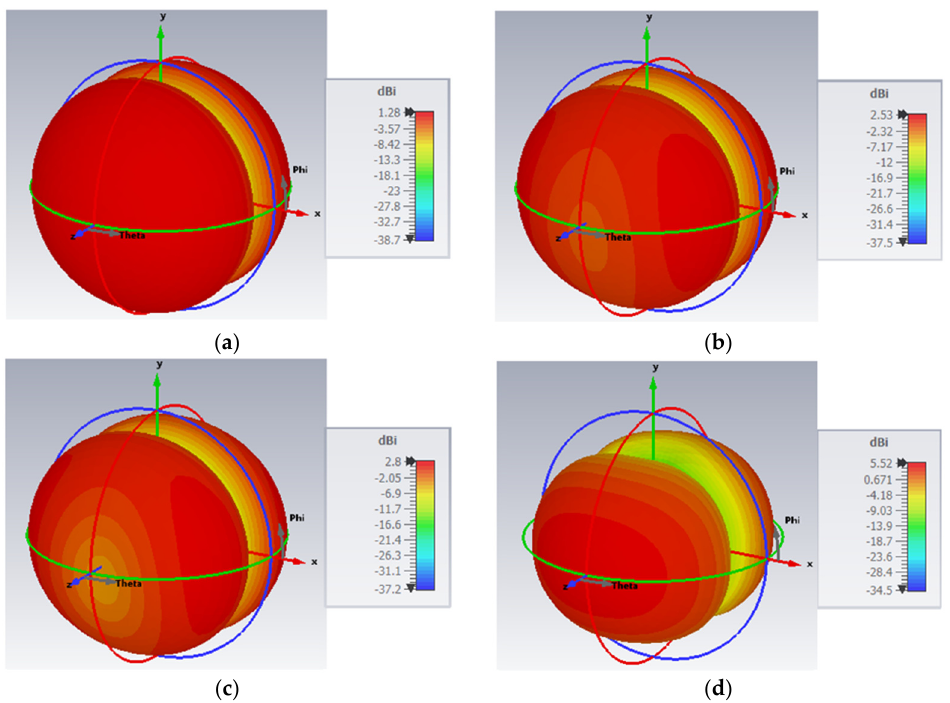
Figure 6. Two–element MIMO antenna polar radiation pattern representation; ( a ) 3.5 GHz; ( b ) 4.0 GHz; ( c ) 4.5 GHz; and ( d ) 5.5